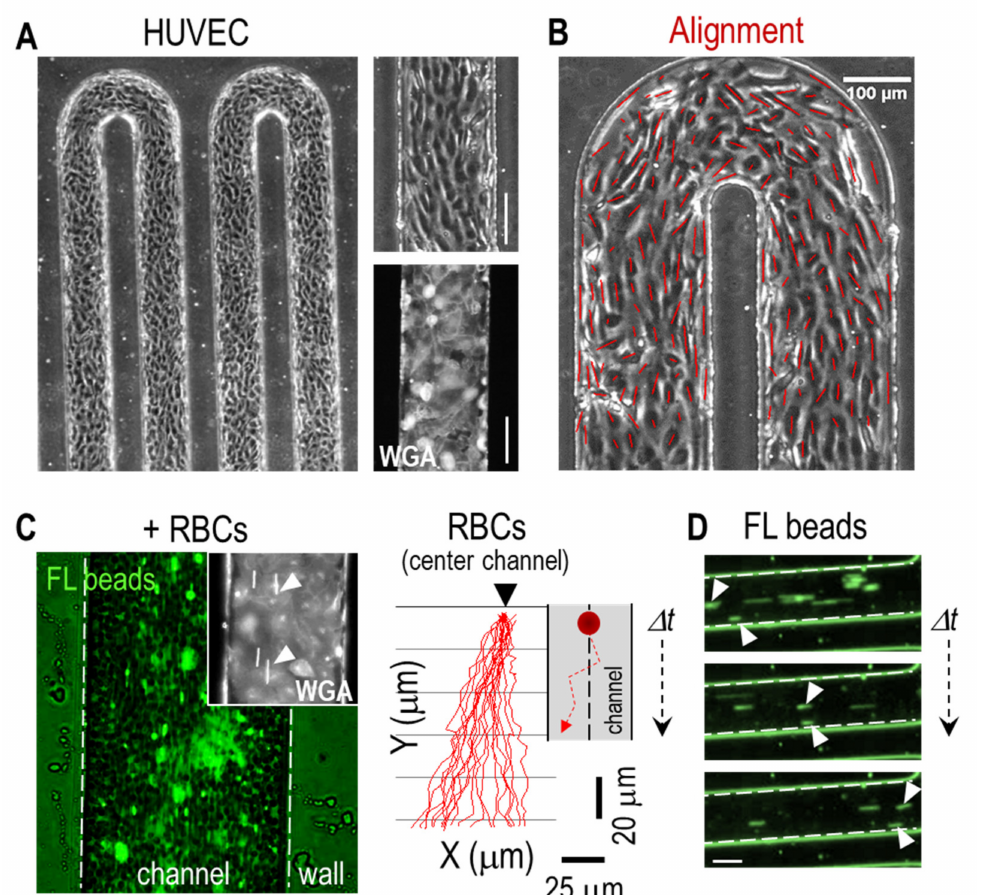
Figure 3. Vessel-on-a-chip with endothelial cells and red blood cells (RBCs). ( A ) (Left) Phase contrast microscopy image showing the serpentine microchannel coated with a confluent layer of HUVEC after 3–4 days in culture; (Right) detailed images (phase contrast and Wheat Germ Agglutinin Alexa (WGA) staining) showing the uniformity of the cell layer). ( B ) Flow-induced cell alignment (cell orientation is indicated in dark red). ( C ) (Left) Overlay of fluorescent and brightfield microscopy images showing the flow of RBCs and fluorescent beads along the channel (Movie S1). Inset, WGA- stained HUVEC cells with fluorescent beads (white arrowheads) flowing along the channel. (Right) Trajectory of fluorescent beads along the endothelium-like microchannel showing a significant degree of scattering due to cellular collisions (0.5 µ L min − 1 ). For the analysis, we selected the beads flowing in the center of the channel. ( D ) Time sequence of flowing fluorescent beads. The bead next to the channel wall displays a lower velocity compared to the one in the center (white arrowheads). Scale bars: 100 µ